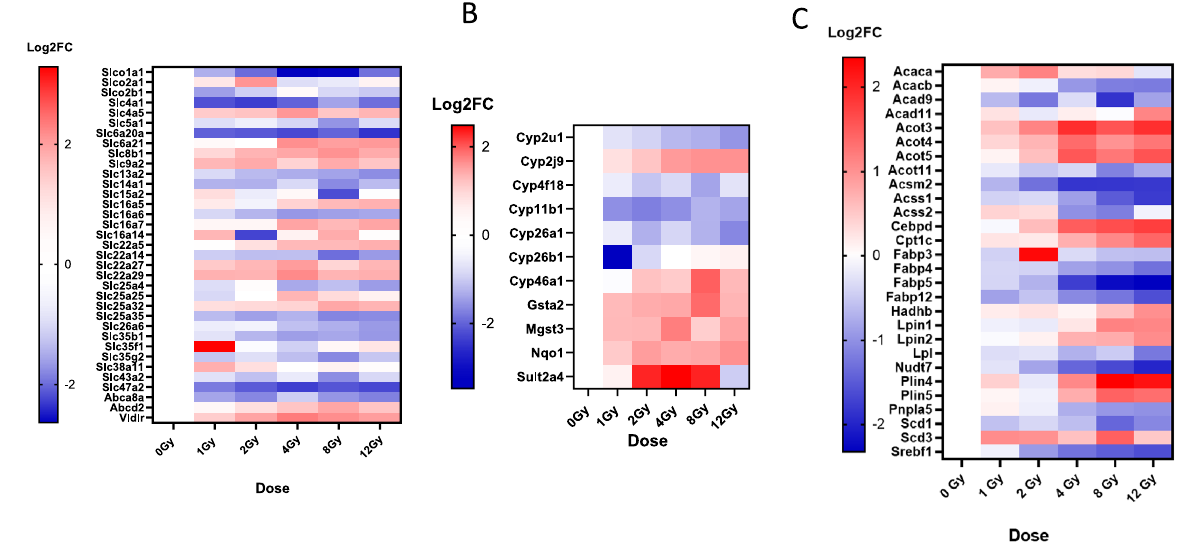
Figure 3. Drug and fat metabolism are dysregulated by radiation injury. Heatmaps of solute carriers (SLC) (A), phase I and phase II metabolism genes (B), and fat metabolism (C) are displayed. Only genes which were shown to be significantly altered ((log2FC > 1), p < 0.01) in at least one dose are displayed. White indicates control samples. Red indicates upregulation compared to control while blue indicates downregulation compared to